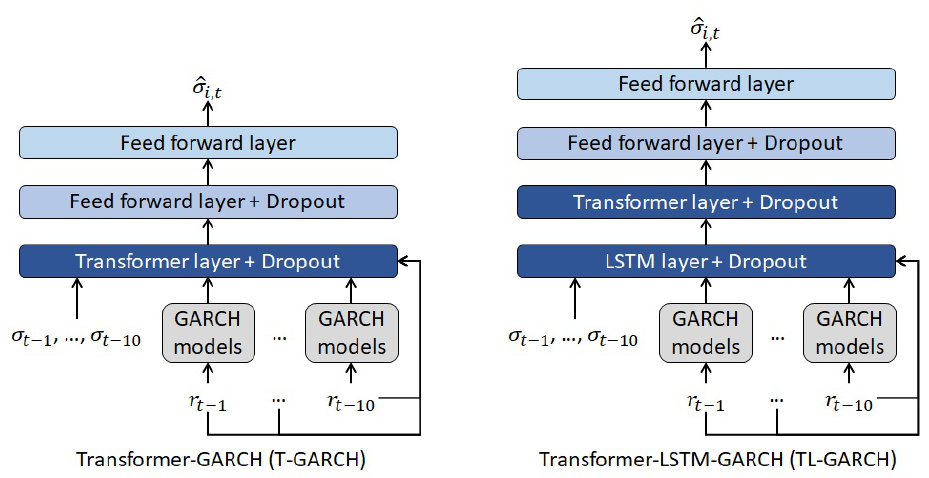
Figure 4. T-GARCH and TL-GARCH volatility